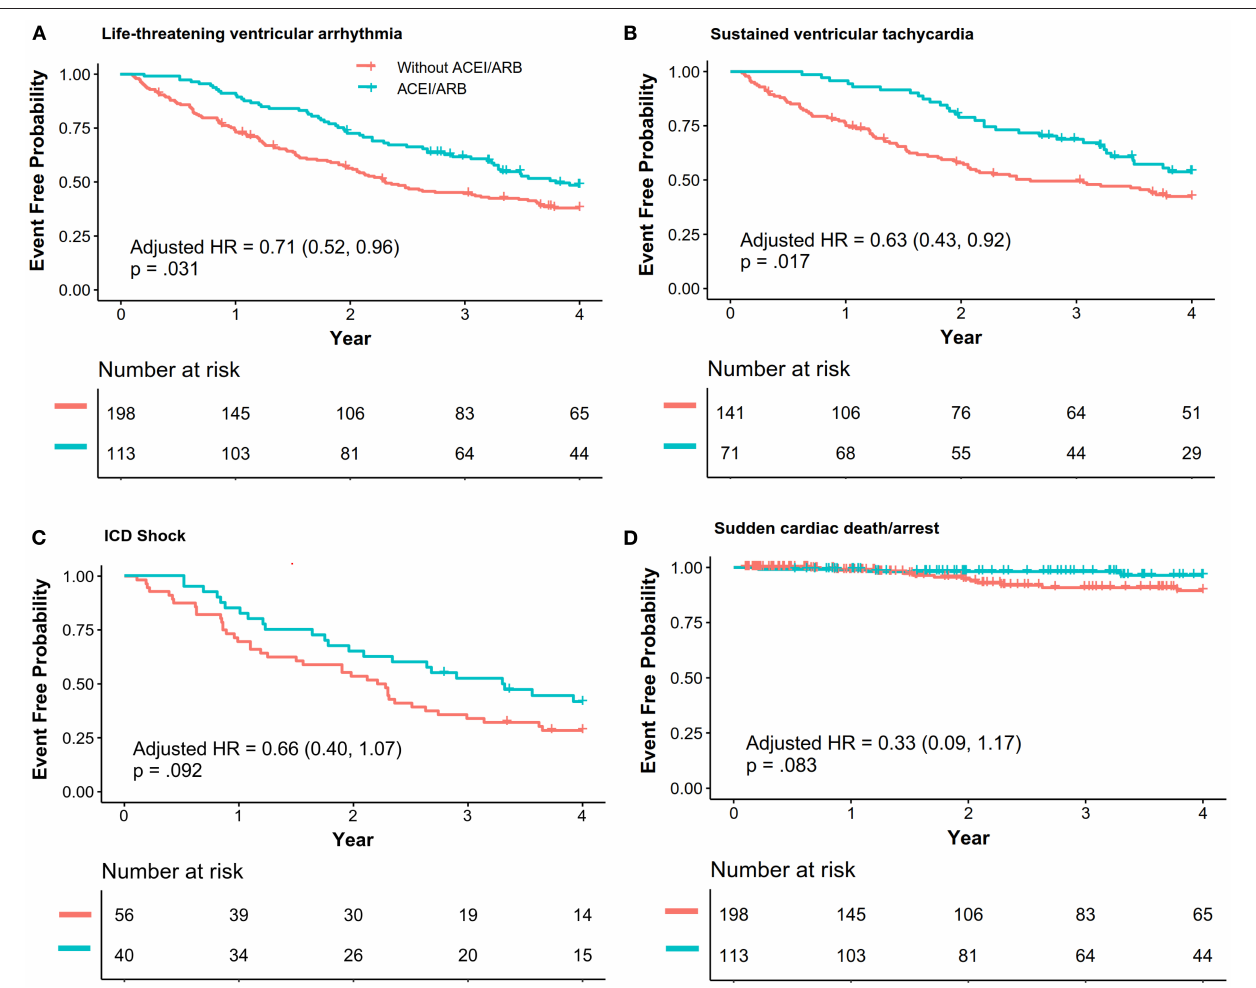
FIGURE 2 | The association between ACEI/ARB treatment and recurrence of life-threatening ventricular VAs. Data were analyzed with composite outcomes as shown in (A) , and each outcome is individually shown in (B–D) . Hazard ratio (HR) and p -values were calculated via a Cox proportional hazard model, and the results were adjusted with Model I [right ventricular ejection fraction (baseline), percentage of late gadolinium enhancement in the right ventricle, N-terminal pro-brain natriuretic peptide, ICD, catheter ablation]. ACEI, angiotensin-converting enzyme inhibitors; ARB, angiotensin receptor blockers; VA, ventricular arrhythmia; VT, ventricular tachycardia; ICD, implanted cardiac defibrillator; SCD/A, sudden cardiac death/arrest.